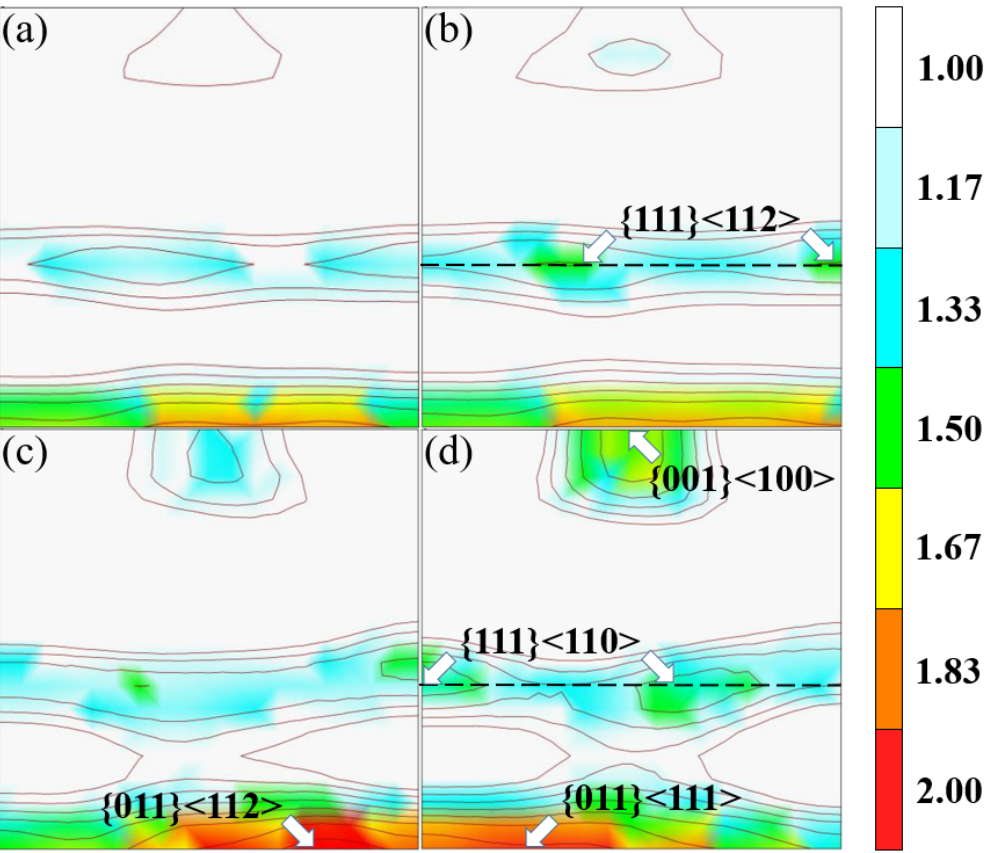
Figure 3. The texture distribution of the hot rolled sheets ( a ) Q380, ( b ) Q420, ( c ) Q460 and ( d ) Q500.